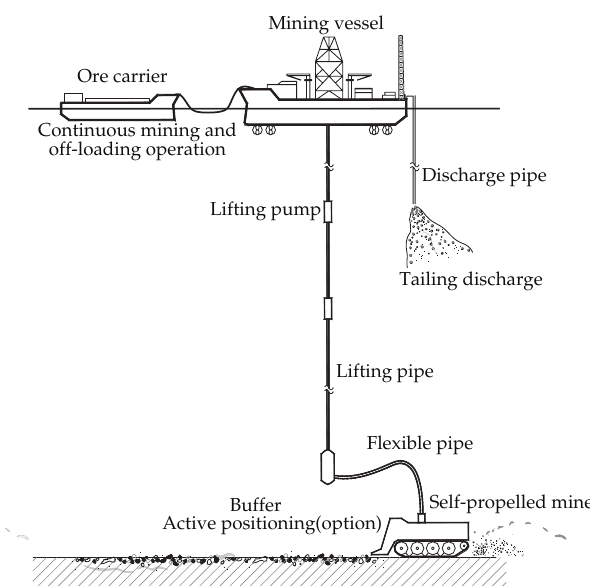
Figure 1: Schematic diagram of the integrated deep-sea mining system (cid:4) 1 (cid:5)